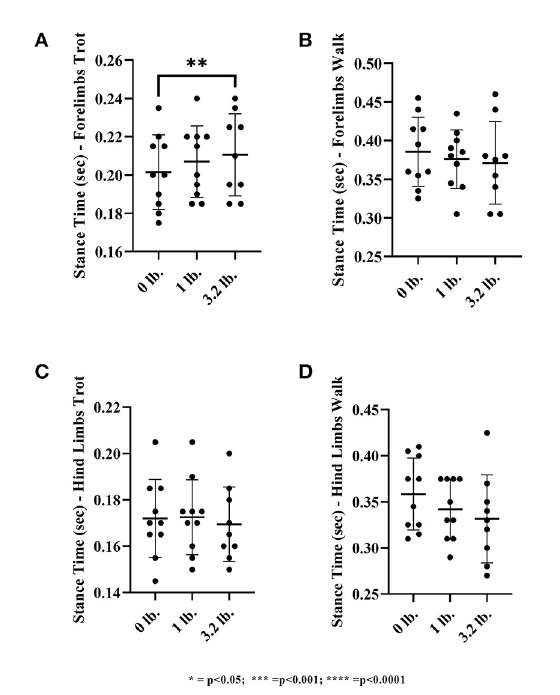
FIGURE8 Stance time of the front limb and hind limbs at walk and trot. (A) Front limb trot, (B) Front limb walk, (C) Hind limb trot, (D) Hind limb walk ( N = 10). The asterisks denote different levels of significance (* P ≤ 0.05, ** P ≤ 0.01, *** P ≤ 0.001, **** P ≤